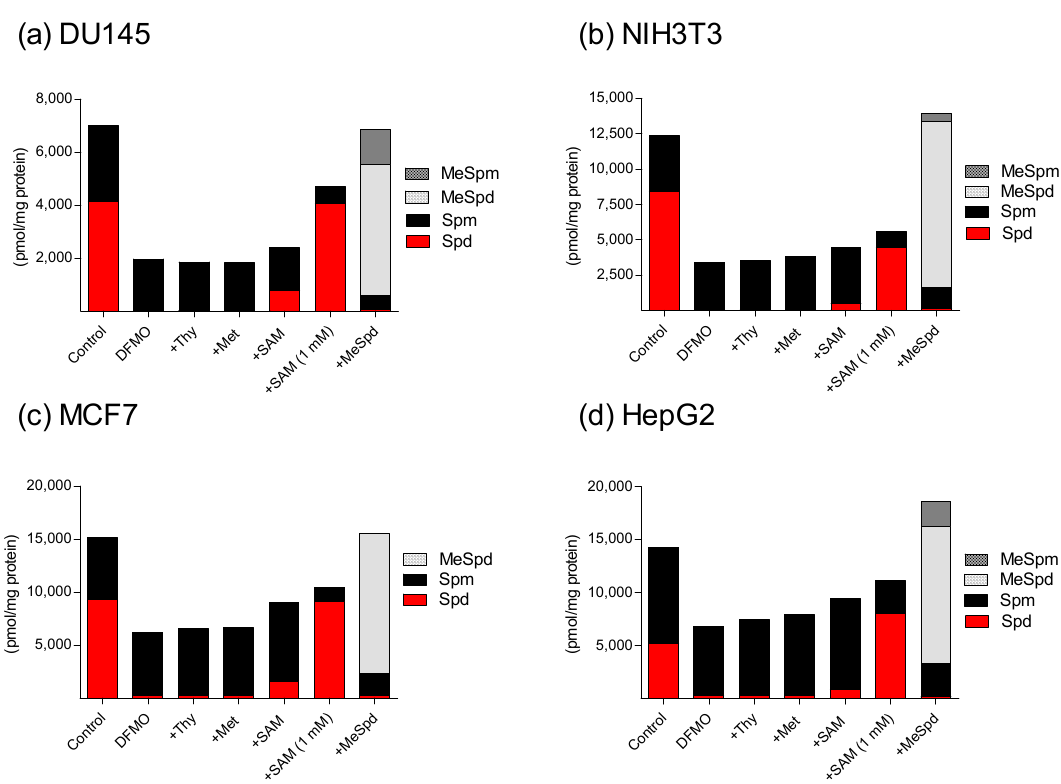
Figure 6. Polyamine levels in ( a ) DU145, ( b ) NIH3T3, ( c ) MCF7 and ( d ) HepG2 cells treated for 3 days with DFMO (5 mM) only (DFMO), or in combination of DFMO with thymidine (Thy, 100 µ M), L -methionine (Met, 100 µ M), SAM (100 µ M or 1 mM), ( S )-1-MeSpd (MeSpd, 100 µ M), or without any additions (Control). Data are means, n = 3, standard deviation markers were omitted for clarity (<10 % for all). MeSpm, ( S )-1-MeSpm.